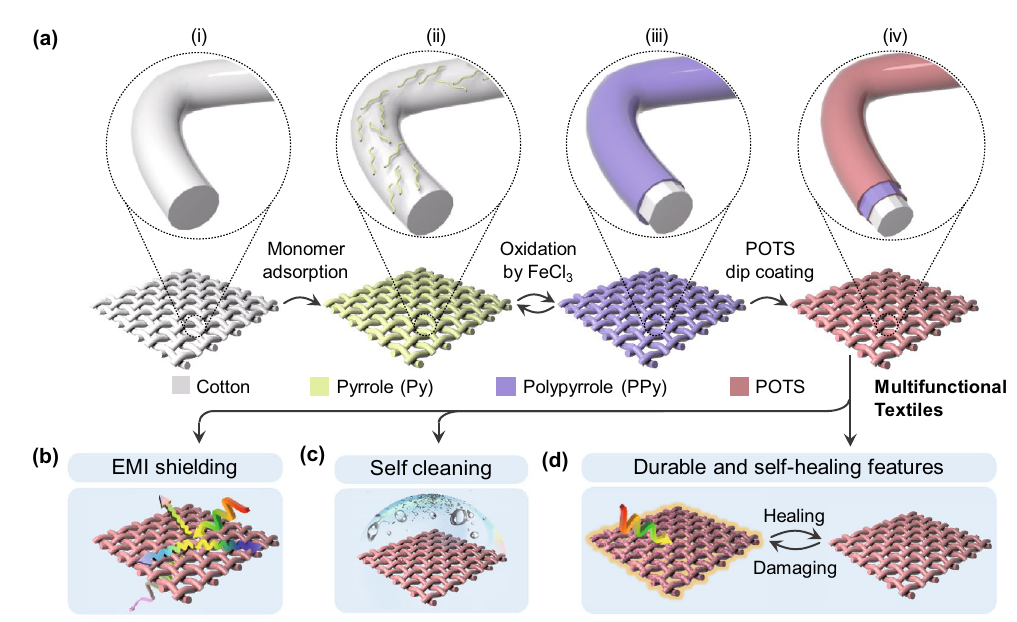
Fig. 1 Schematic of the multifunctional PPy n @POTS fabric preparation. a Fabrication process of PPy n @POTS fabrics via a dip-coating approach. The desired number of PPy coating layers can be obtained by repeating the adsorption-oxidation process before the final protection layer coating of POTS. b–d The multifunctionality of the coated fabric with high EMI shielding (PPy), self-cleaning (POTS), and durable per- formance assisted by near-instantaneously self-healing